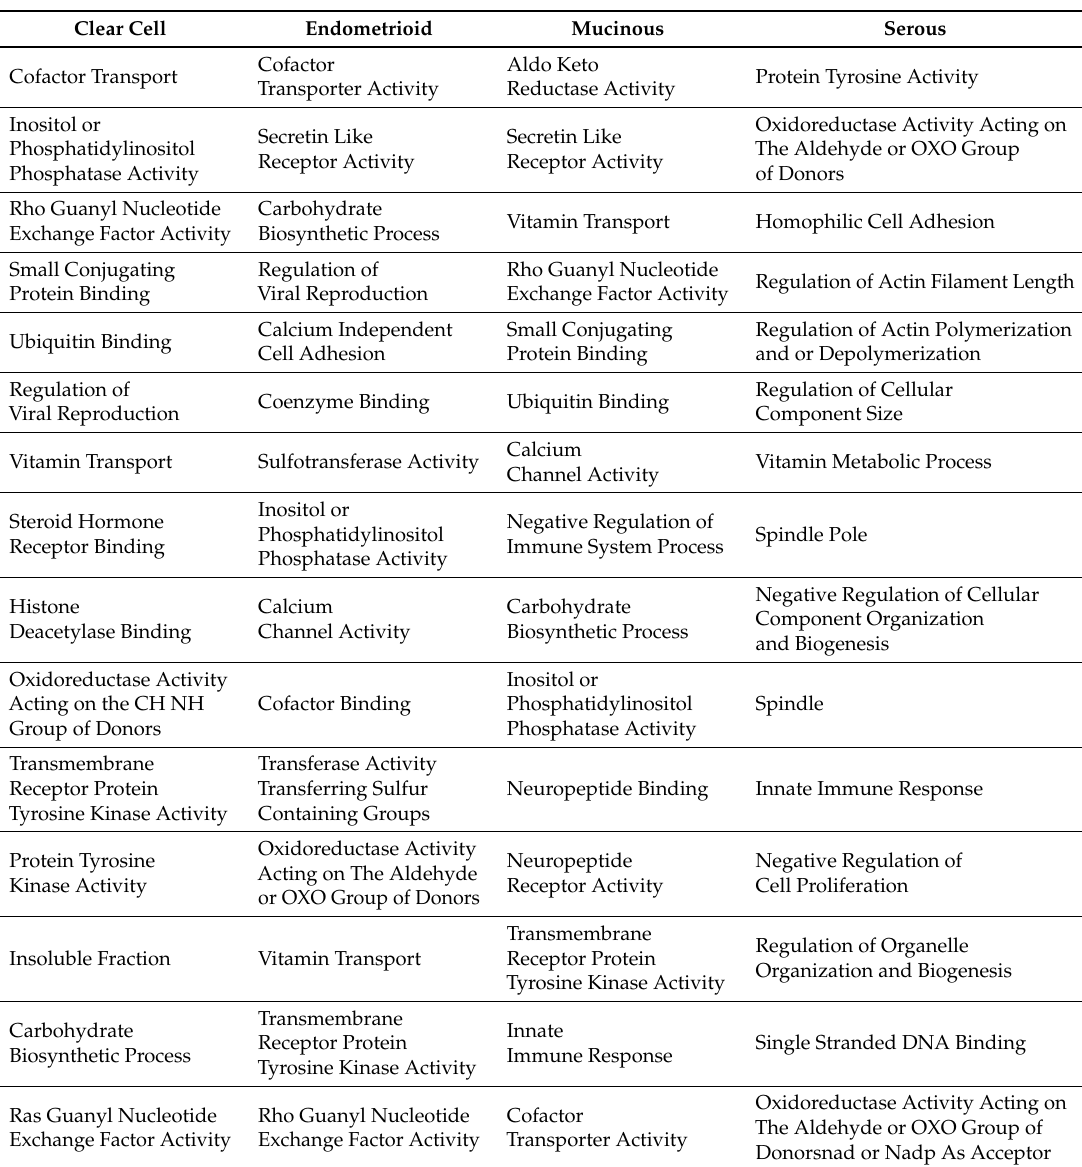
Table 3. The top 15 deregulated Gene Ontology (GO) terms of the four subtype groups ranked by the p values. This table displayed the top 15 significantly deregulated GO terms of each subtype. GO: Gene